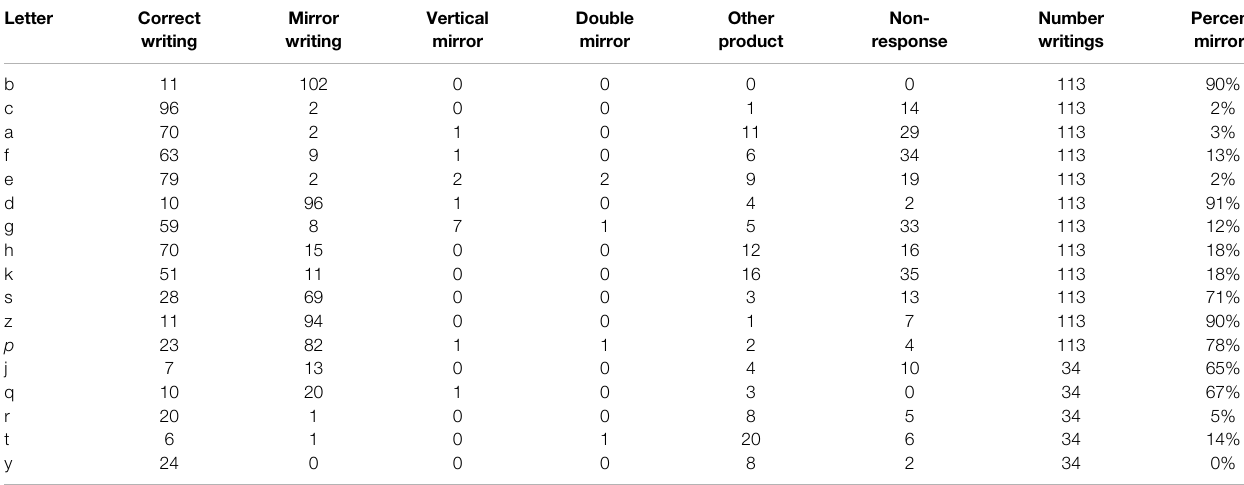
TABLE 3 | Categorization of the letter-writings in the combined “ Immediate after ” and “ After delay ” writing test by the control participants (C +